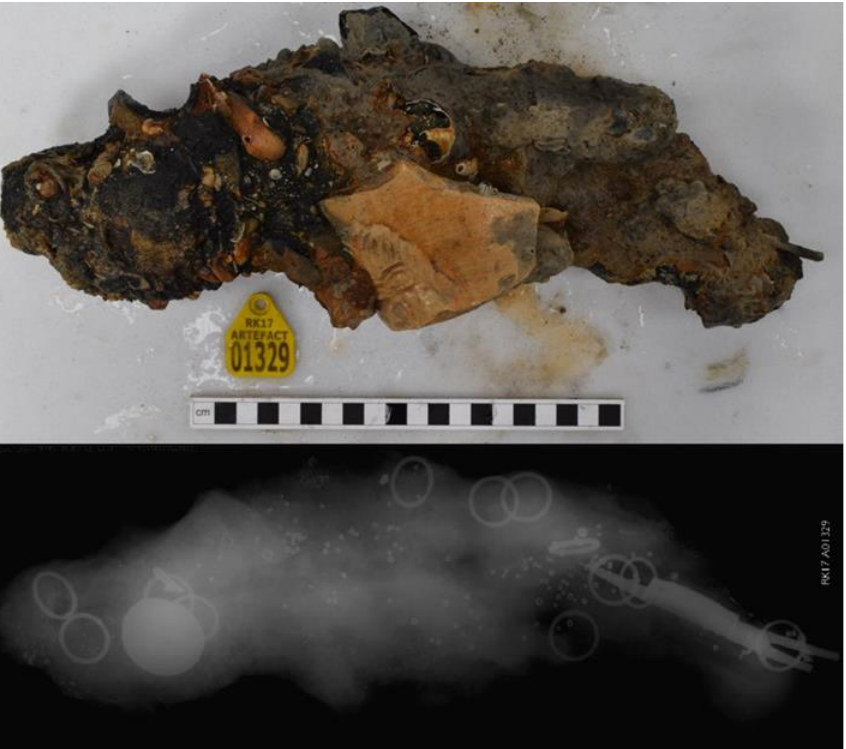
Figure 2. One of the concretions (top) with its corresponding X-ray image (bottom), where rings, a coin, beads and a candle snuffer can be observed.